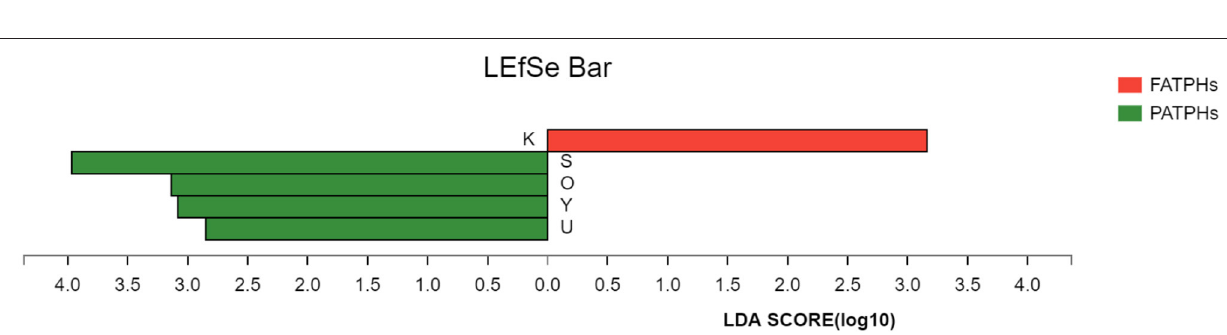
intestinal microbial community composition and